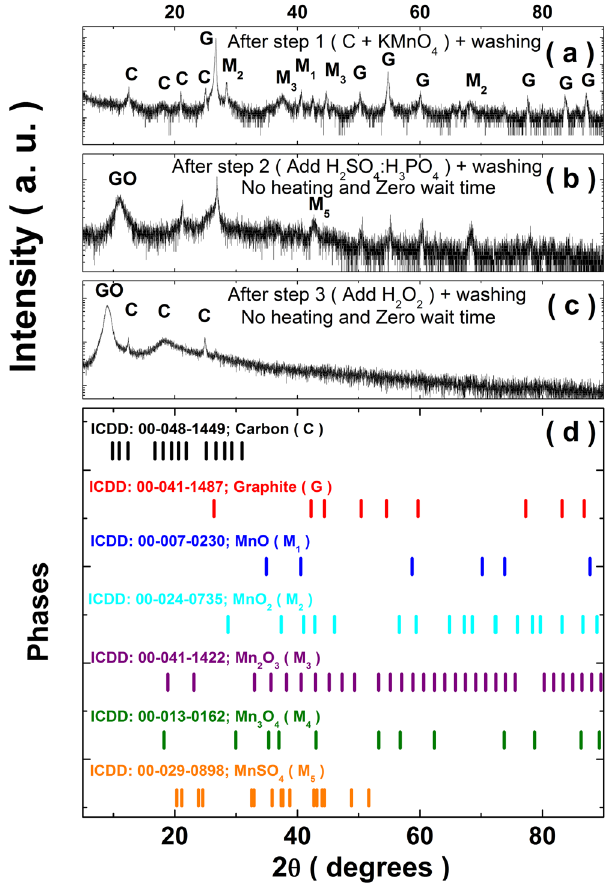
Figure 1. XRD spectra of ( a ) graphite (C) and potassium permanganate (KMnO 4 ) mixture after washing, ( b ) Samples in ( a ) mixed with sulphuric acid and hydrogen peroxide (without heating) after washing and with zero soaking time, ( c ) Sample in ( b ) with heating and washing, ( d ) ICDD card number of carbon, graphite and various Mn